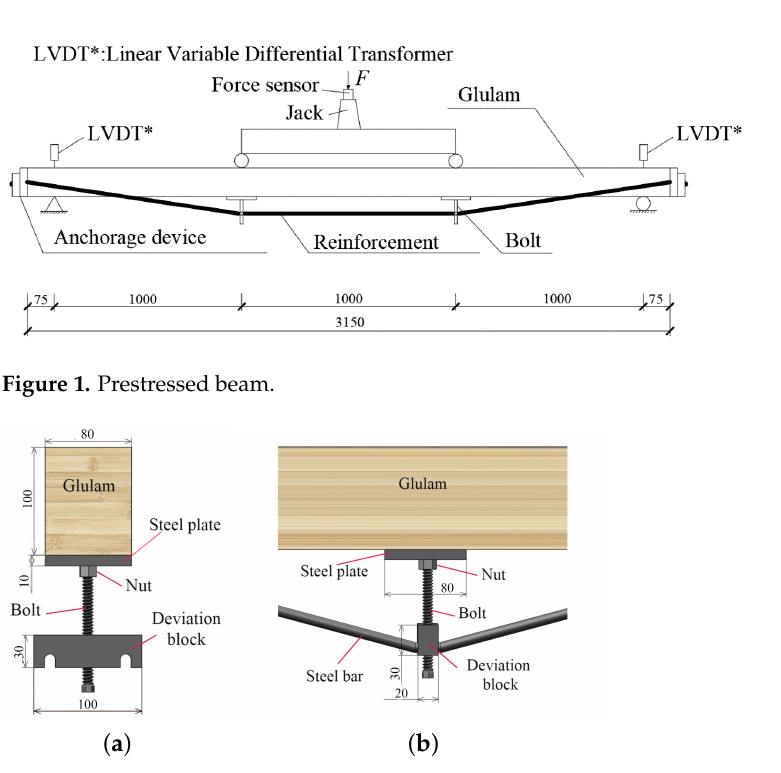
Figure 2. Diagram of screw bolt composition (dimensions are presented in (mm)). ( a ) side view and ( b ) main